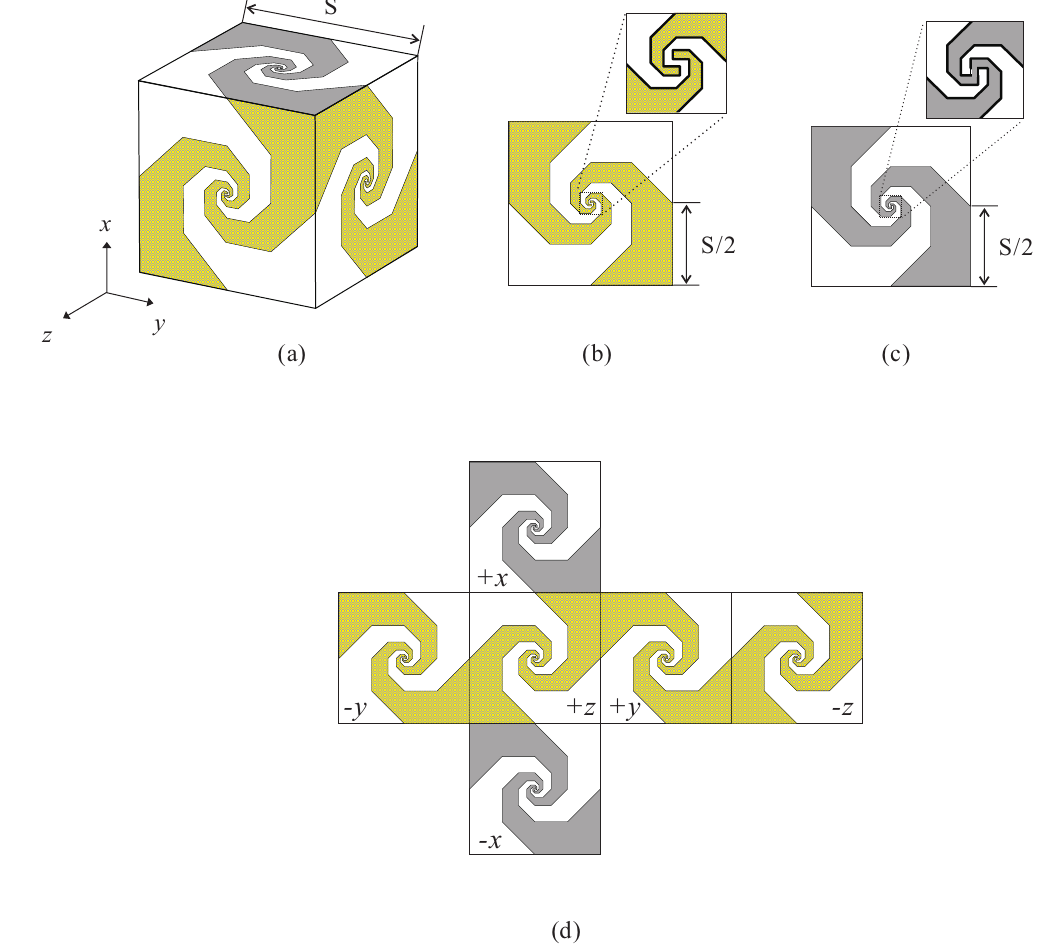
Figure 2. Geometry of the proposed antenna: ( a ) 3-D view; ( b ) Open-state face; ( c ) Short-state face; ( d ) Expanded